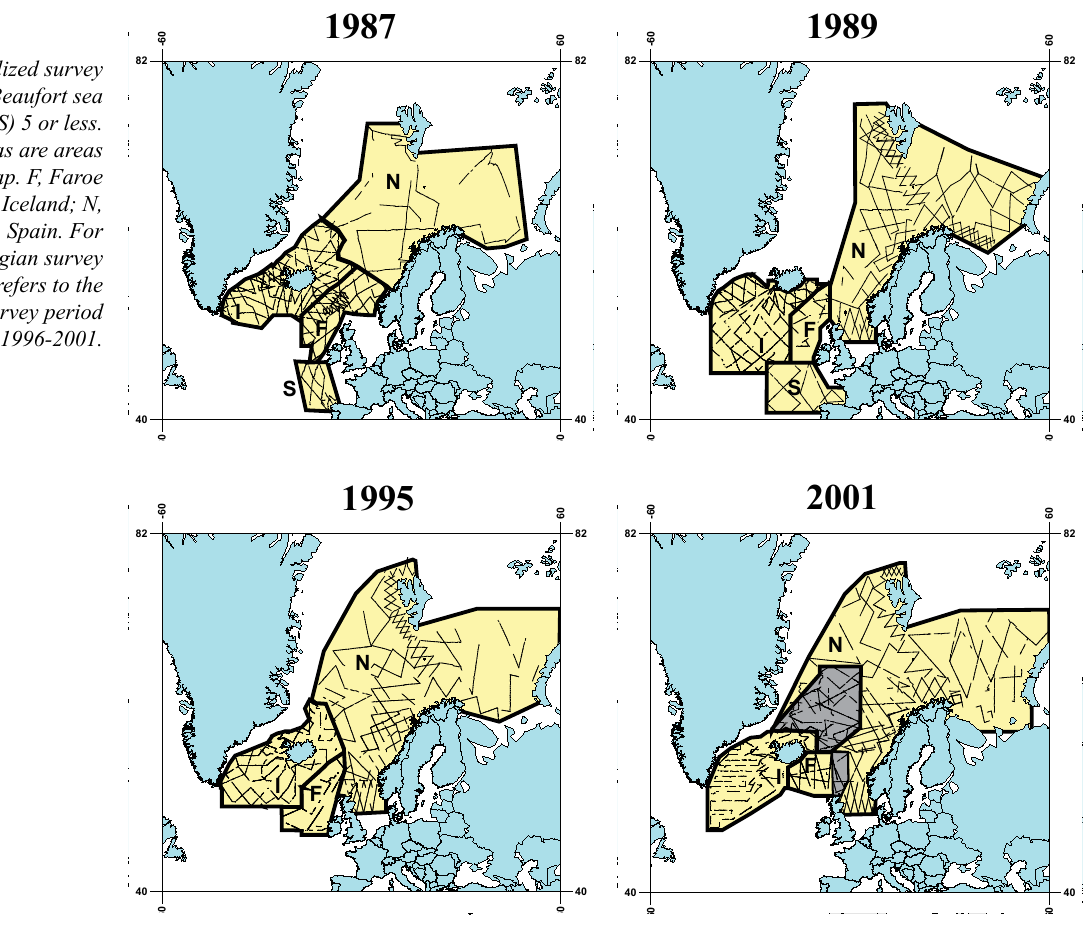
Fig. 1. Realized survey effort in Beaufort sea state (BSS) 5 or less. Gray areas are areas of overlap. F, Faroe Islands; I, Iceland; N, Norway; S, Spain.